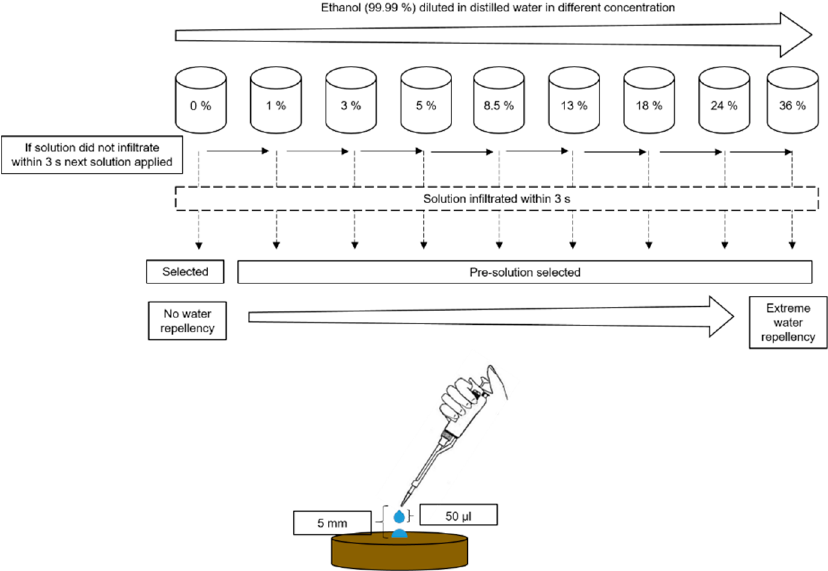
Figure 2. Schematic illustration of the molarity of an ethanol droplet (MED) test.